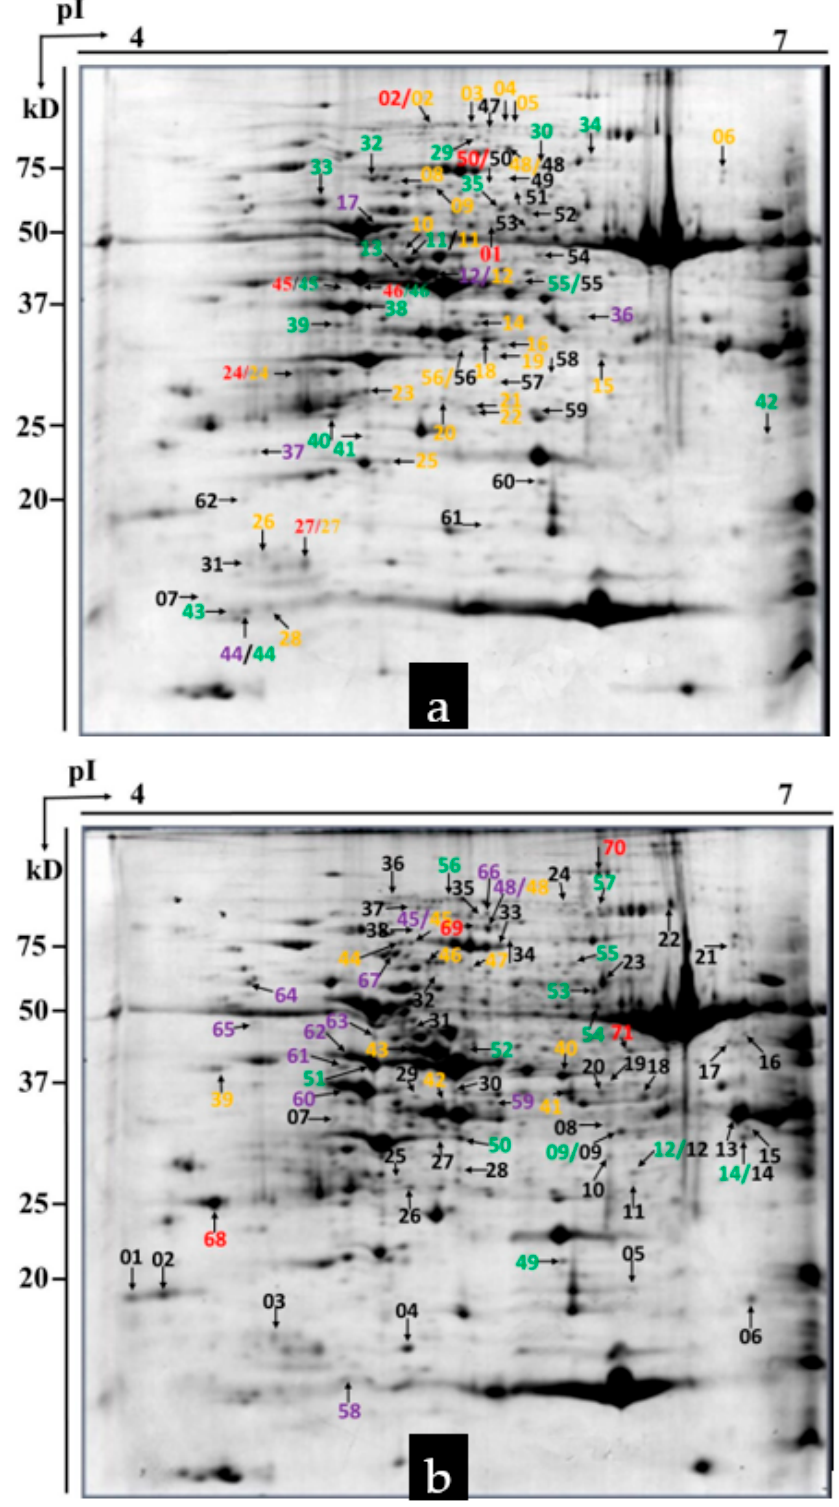
Figure 4. Differences in protein expression between resistant wheat cultivar L699 wheat with and without powdery mildew infection. ( a ) Upregulated proteins are labeled in the representative 2-DE gel of Bgt -inoculated L699 wheat at 24 hpi. ( b ) Downregulated proteins are labeled in the representative 2-DE gel of mock-inoculated L699 wheat at 24 hpi. Red, 2 hpi; purple, 4 hpi; green, 8 hpi; yellow, 12 hpi; black, 24 hpi.